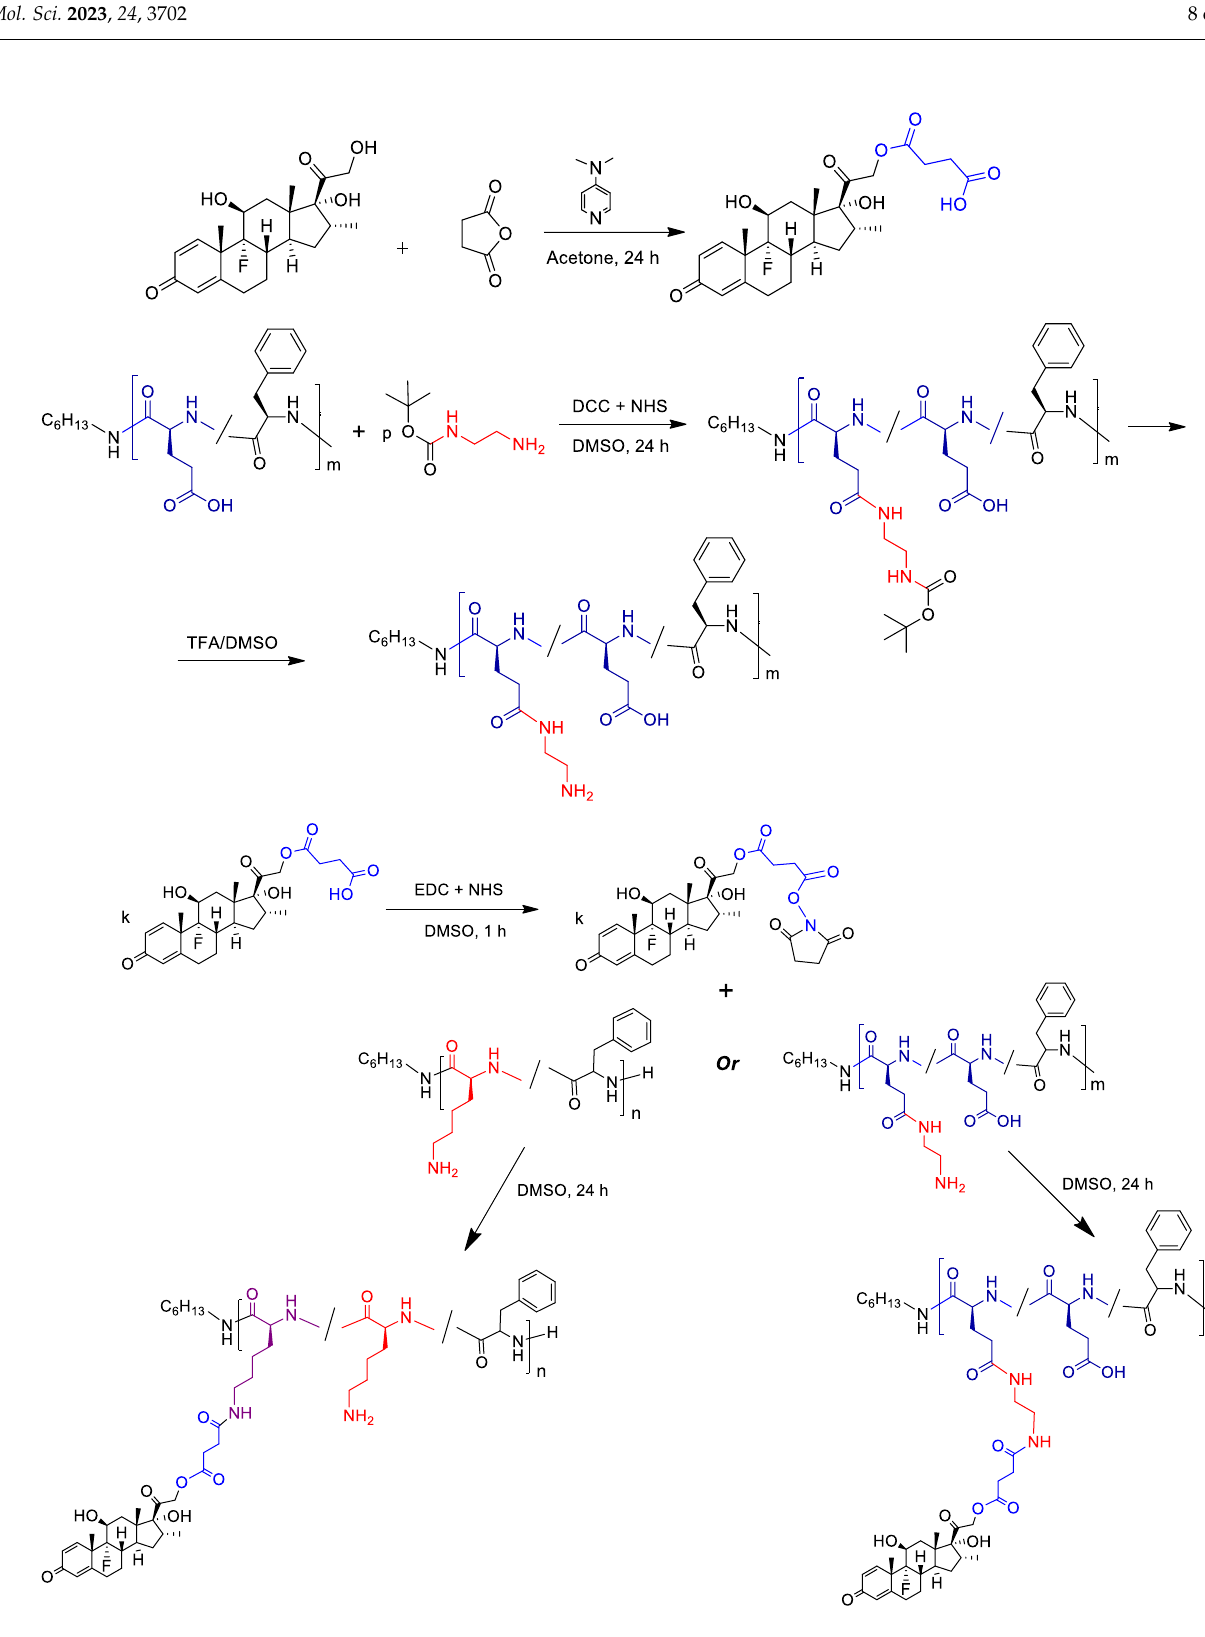
Figure 4. Scheme for the synthesis of DEX-polypeptide conjugates: DEX succinylation ( a ), P[EF] modification with ethylenediamine ( b ), and conjugation of polypeptides with succinylated DEX ( c